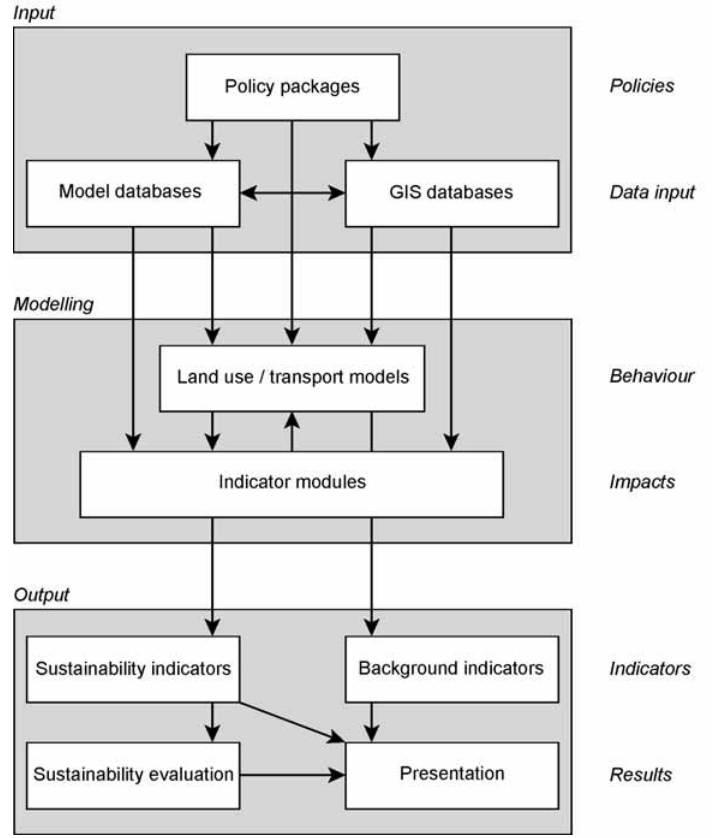
Figure 1. The PROPOLIS model